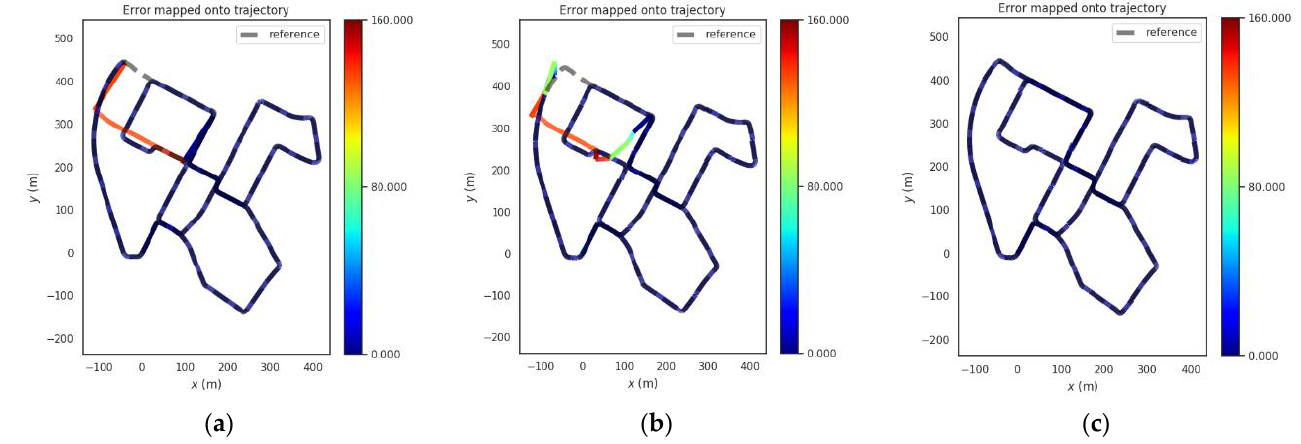
Figure 13. Trajectories of the three methods in urban scene. ( a ), GNSS ( b ), VINS-Fusion, ( c ) PTC-SLM. Table 6. Error parameters of the three methods in urban scene.